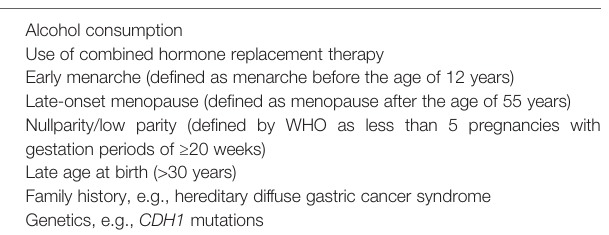
TABLE 1 | A summary of the primary risk factors associated with the development of invasive lobular breast